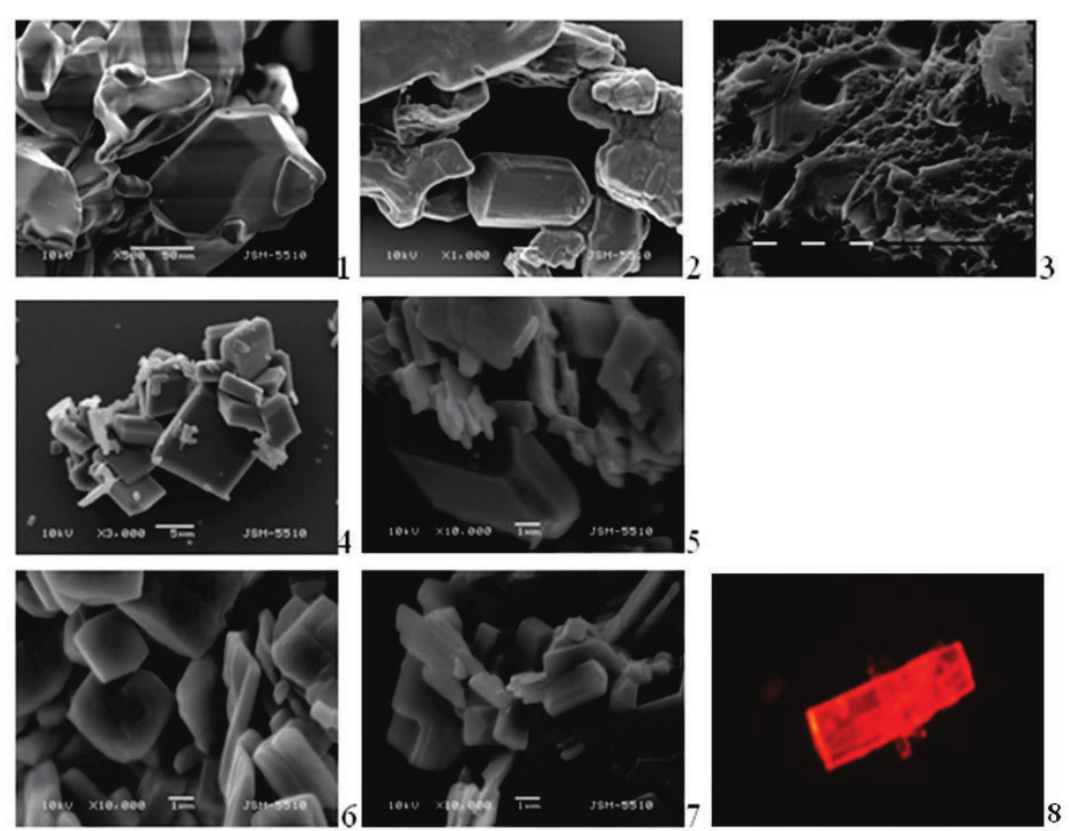
•6H O (1), phen (2) and HTTA (3); “wet” (4, 5) and mechanochemically (6, 7) produced Eu(TTA) 3 2